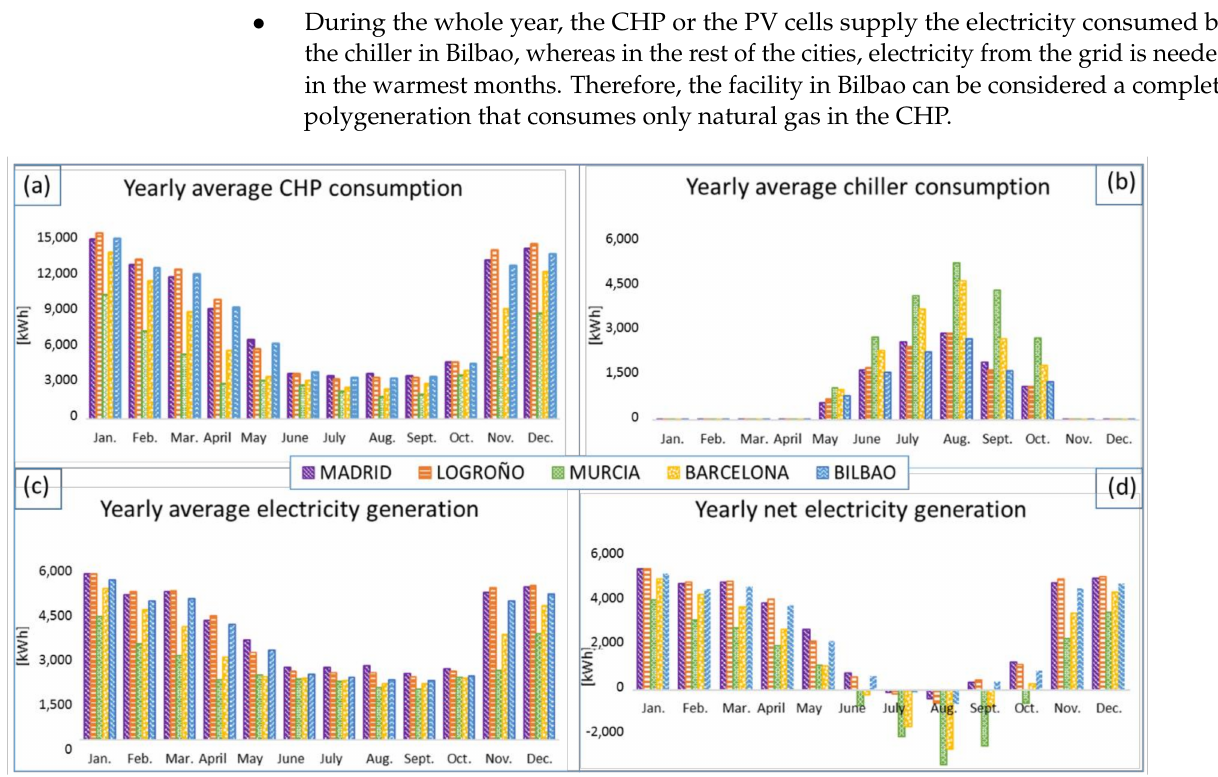
Figure 14. Yearly ( a , b ) energy consumption and ( c , d ) electricity generation in the 5